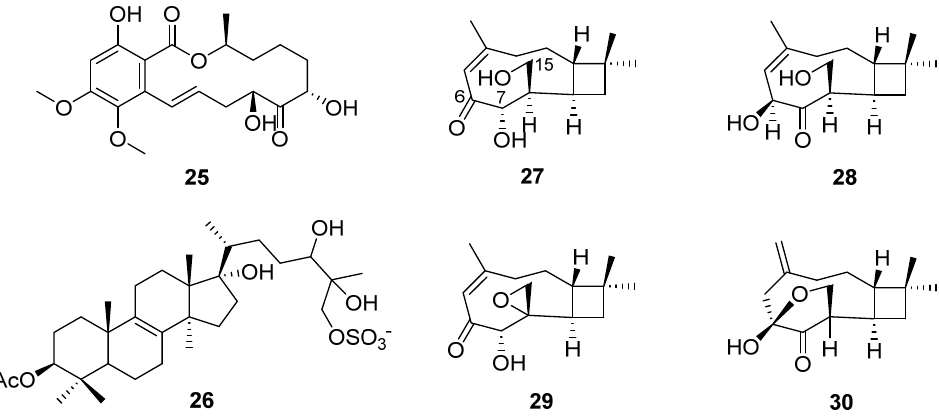
Figure 8. Structure of lactone 25 , steroid 26 and terpenoids 27 – 30